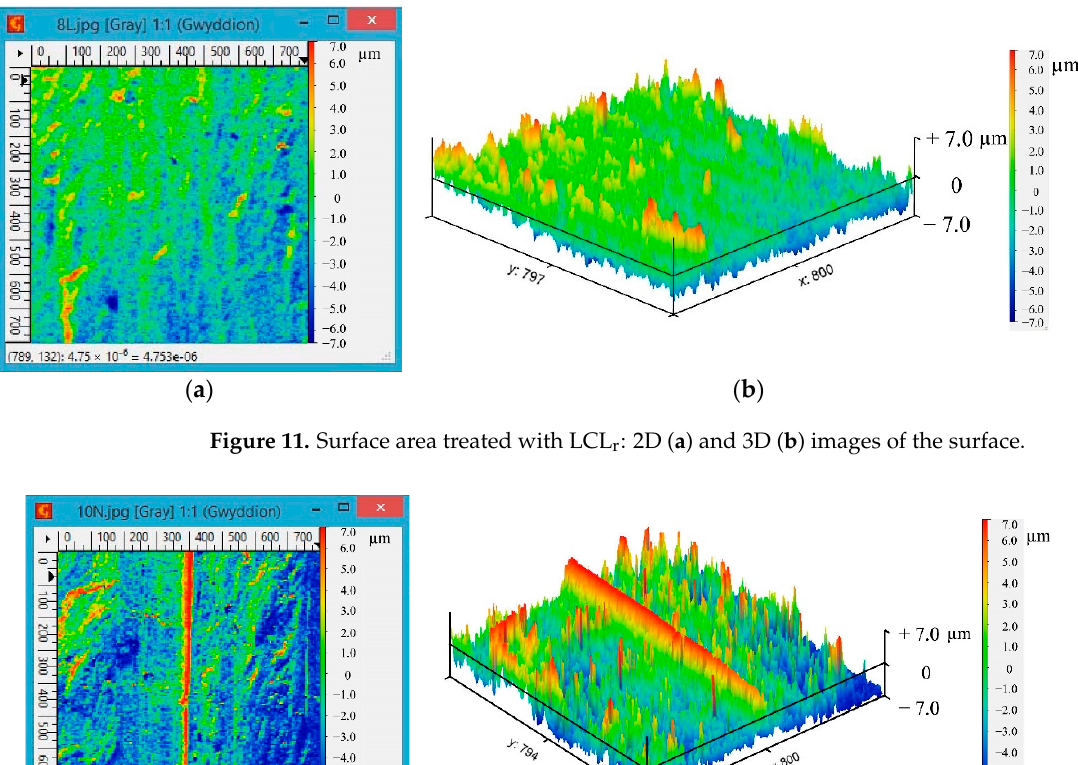
Figure 10. Surface area treated with LCLs: 2D ( a ) and 3D ( b ) images of the surface.